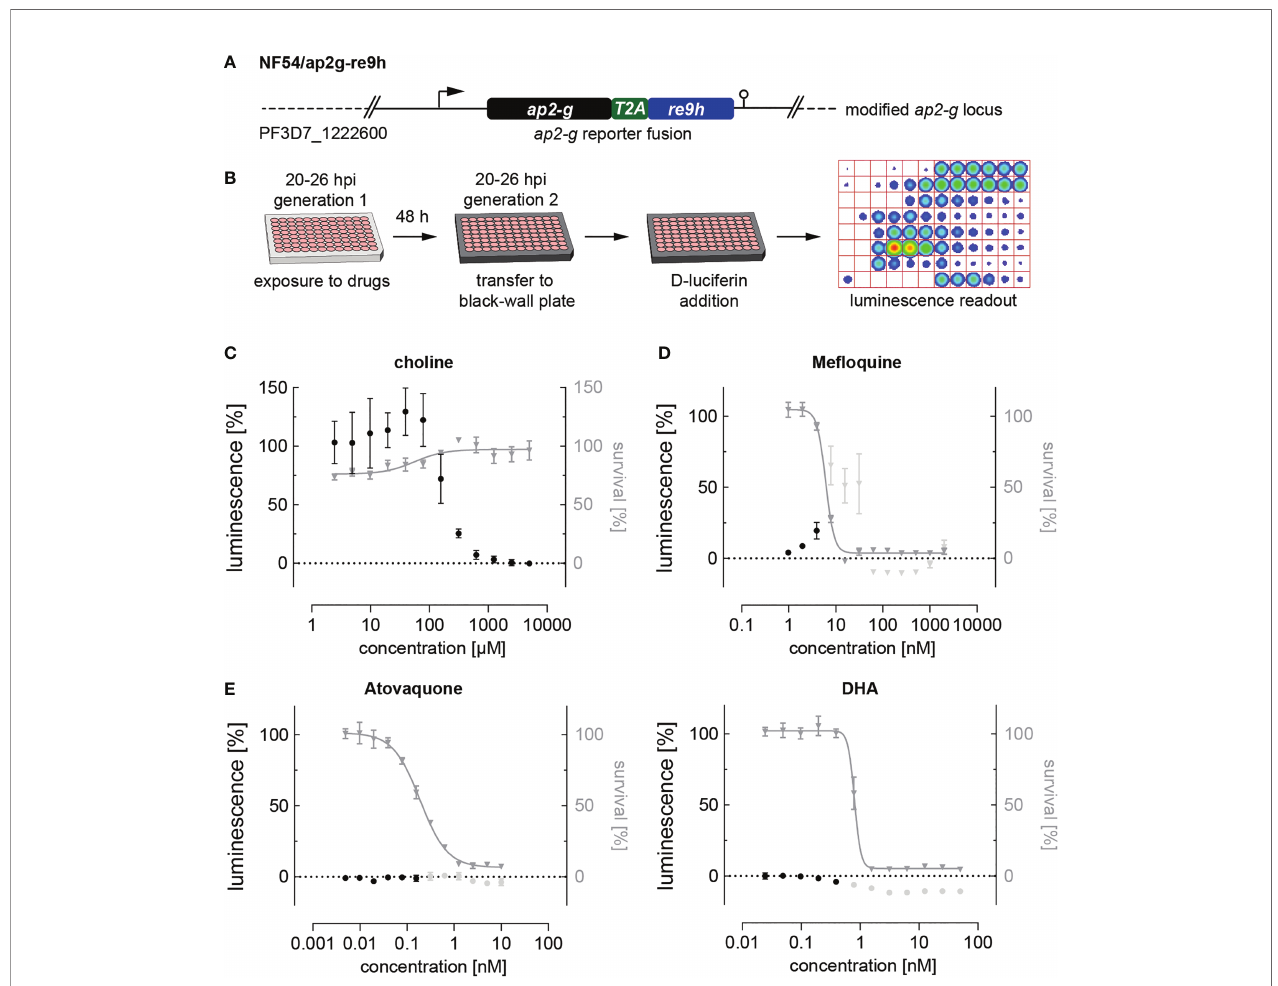
FIGURE 3 | Luciferase-based quanti fi cation of sexual commitment. (A) Schematic of the modi fi ed ap2-g locus in NF54/ap2g-re9h parasites. re9h , gene encoding red-shifted fi re fl y luciferase RE9H. T2A, self-cleaving peptide. (B) Experimental setup of RE9H luciferase-based quanti fi cation of SCRs. (C) Dose-response effect of choline on the SCR (black bullets) and parasite survival (grey triangles). Data points represent the mean of three independent biological replicate experiments. Error bars represent the standard error of the mean. (D) Me fl oquine induces sexual commitment within a narrow sub-therapeutic window. Mean parasite survival rates and relative RE9H reporter-mediated luminescence as a surrogate for SCRs are indicated by grey triangles and black bullets, respectively. Grey bullets represent SCRs at compound concentrations above the IC50. Values are normalized to the corresponding control conditions (-SerM for SCR) and (-SerM/choline for survival). n=3; error bars represent the standard error of the mean. (E) Neither atovaquone nor DHA induce sexual commitment. Mean parasite survival rates and relative RE9H reporter- mediated luminescence as a surrogate for SCRs are indicated by grey triangles and black bullets, respectively. Grey bullets represent SCRs at compound concentrations above the IC50). Values are normalized to the corresponding control conditions (-SerM for SCR) and (-SerM/choline for survival). n=3; error bars represent the standard error of the